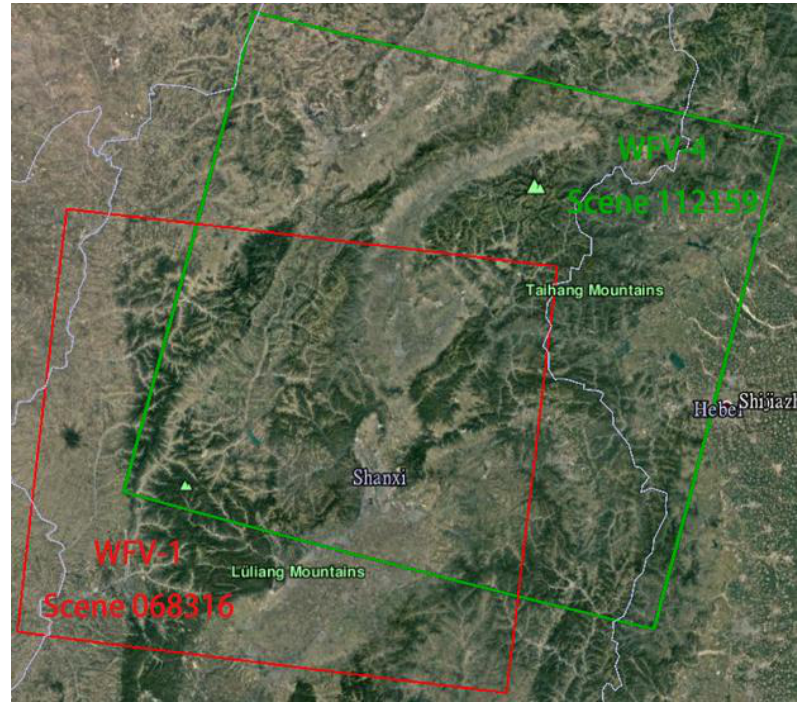
Figure 5. Coverage of the stereo mapping images.